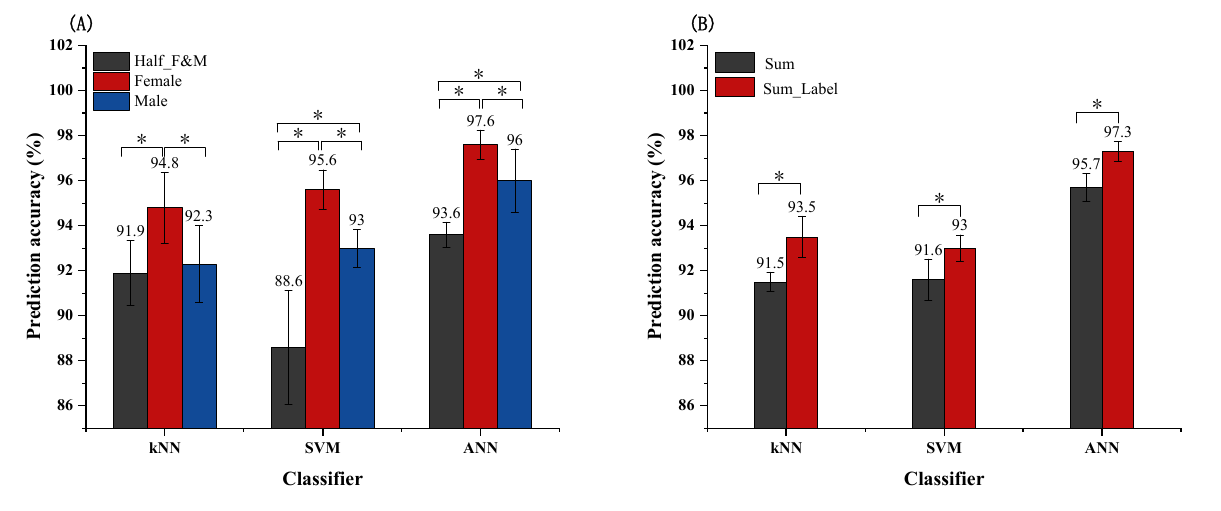
Figure 6. Results of statistical analysis of the total prediction accuracy of three classifiers (kNN, SVM and ANN) with 5-fold cross validation, applied to a hand gesture recognition test set of two methods considering sex differences. ( A ) Differentiation of sex datasets. ( B ) Addition of a sex label. (*) represents p < 0.05 between the total prediction accuracy of the two datasets. Error bars represent standard errors.